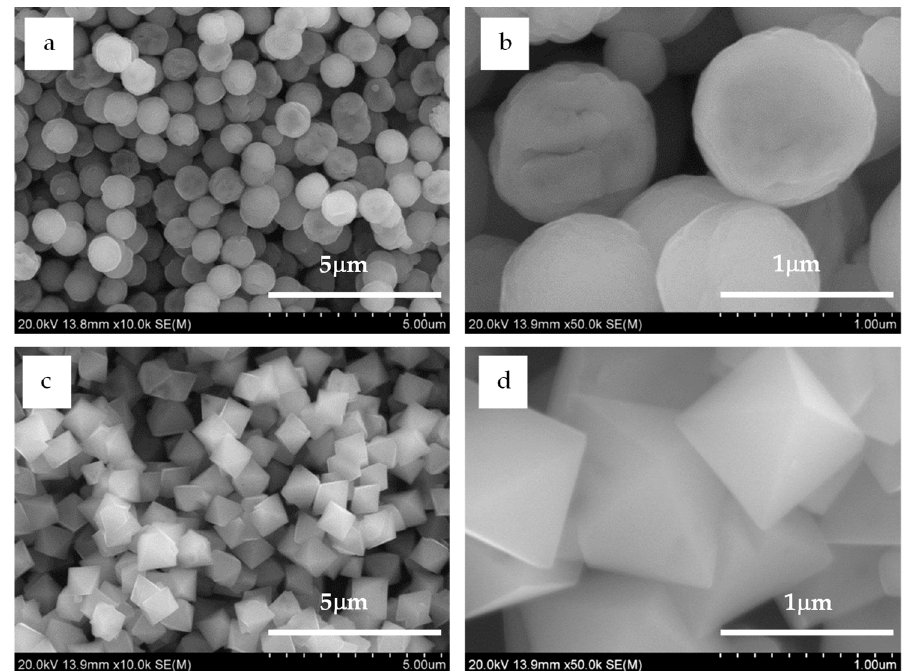
Figure 3. Typical scanning electron microscopy images of the products ( a , b ). Spherical Fe 3 O 4 particles prepared by reduction of α -FeOOH in the mixed solvent with 9 vol. % water concentration at 200 ◦ C for 24 h; ( c , d ) octahedral Fe 3 O 4 particles prepared by reduction of α -FeOOH with 12 vol. % water concentration at 200 ◦ C for 48